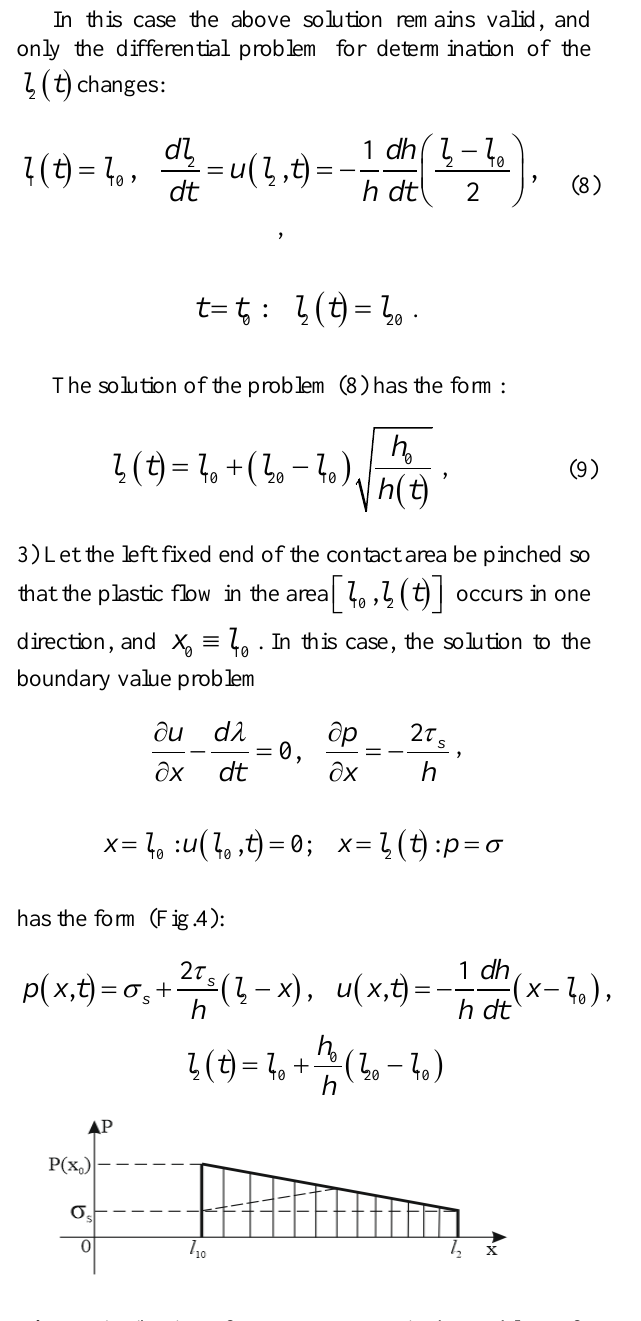
Fig.4. Distribution of contact pressure in the problem of the spreading of a plastic strip with a pinched left